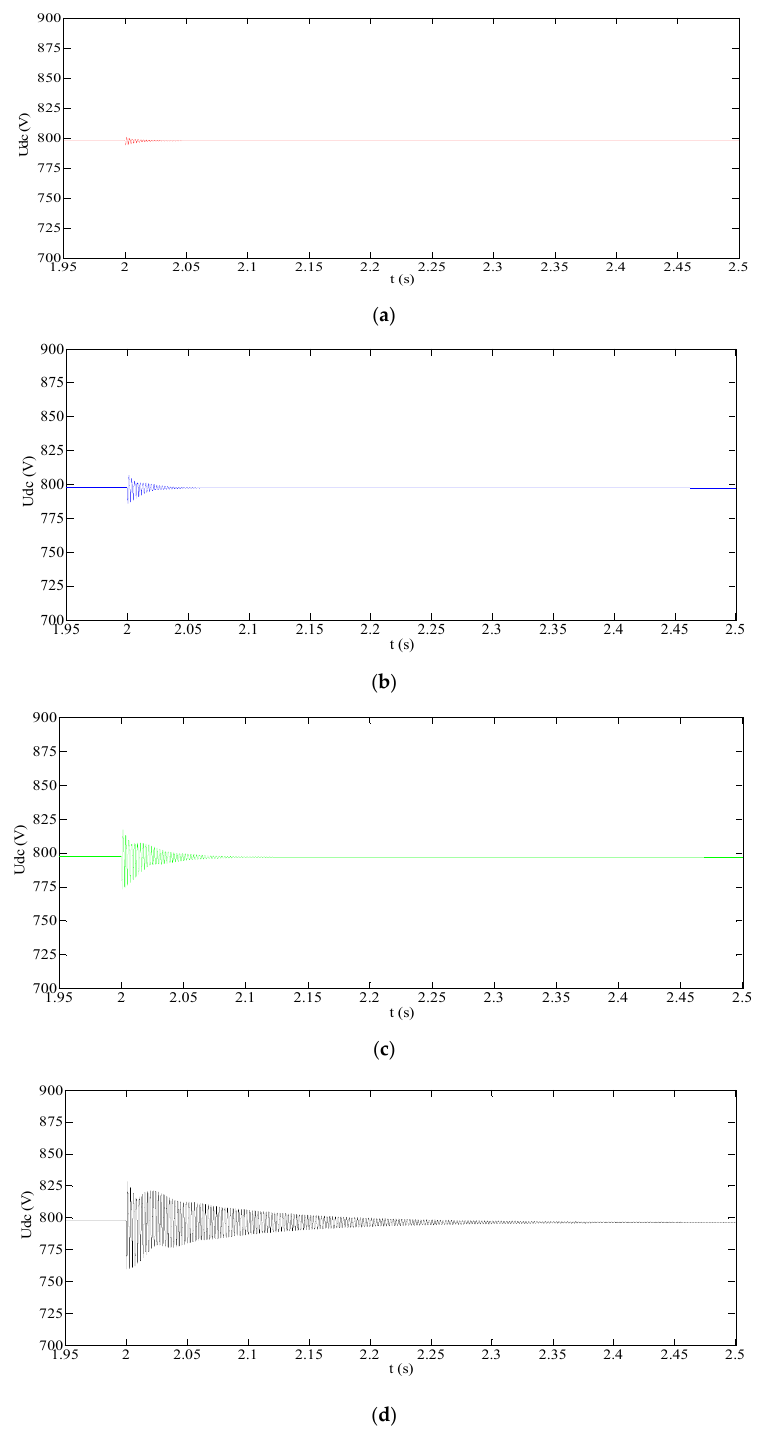
Figure 9. Simulation results of U dc : ( a ) P s changes from 90 kW to 100 kW; ( b ) P s changes from 90 kW to 120 kW; (c) P s changes from 90 kW to 150 kW; (d) P s changes from 90 kW to 180 kW.